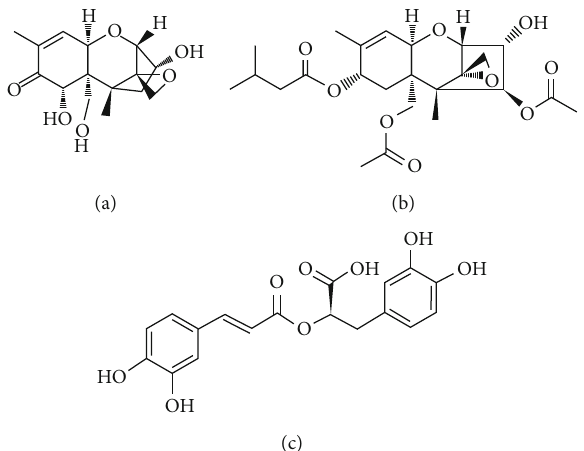
Figure 1: Chemical structures of the tested food-borne compounds: (a) DON, (b) T-2 toxin, and (c)